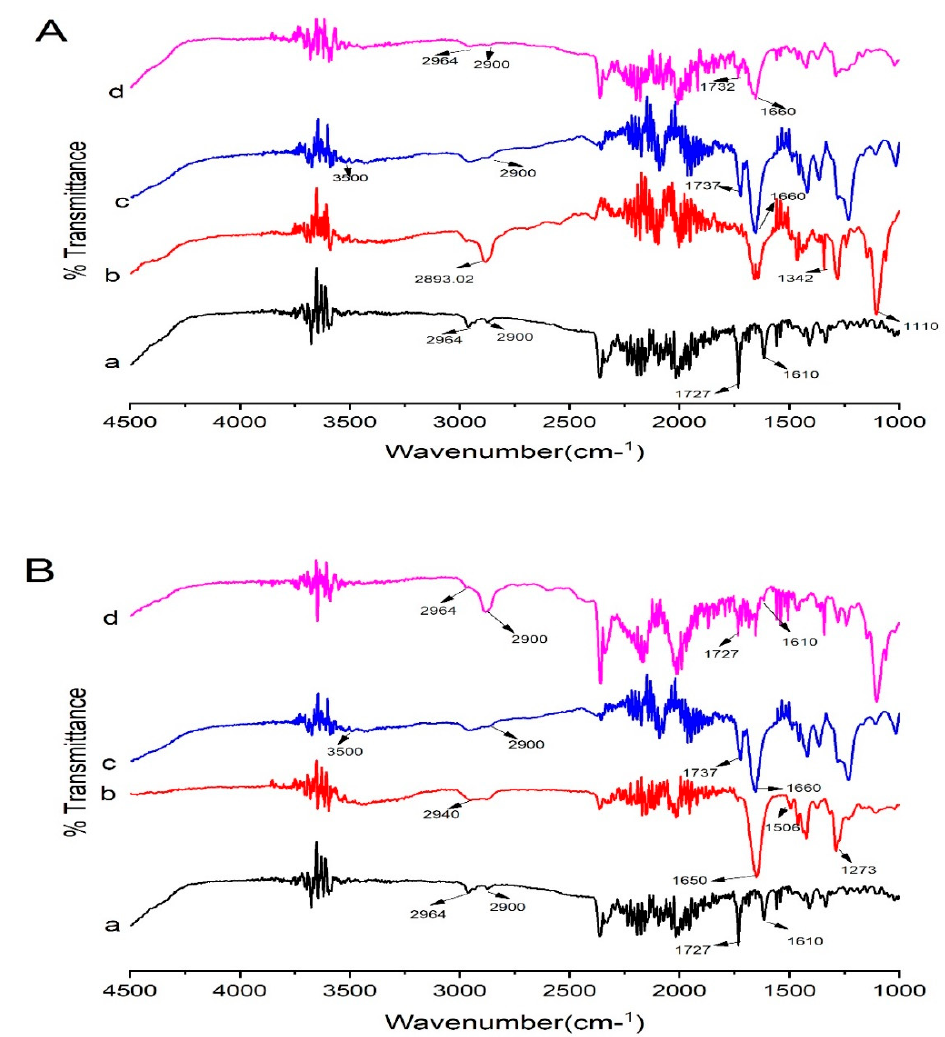
Figure 11. FTIR data of ( A ) Kolliphor ® P 407-based ternary solid dispersions formulation: (a) pure Irbesartan, (b) Kolliphor ® P 407, (c) Kollidon ® VA 64, (d) ternary system KP407 (TD 3 ). ( B ) Polyvinylpyrrolidone-K30-based ternary solid dispersions formulation: (a) pure Irbesartan, (b) Polyvinylpyrrolidone-K30, (c) Kollidon ® VA 64, (d) ternary solid dispersion KPVP (TD 3 ). Note: Background noise may be present along with signals of compounds in FTIR display.